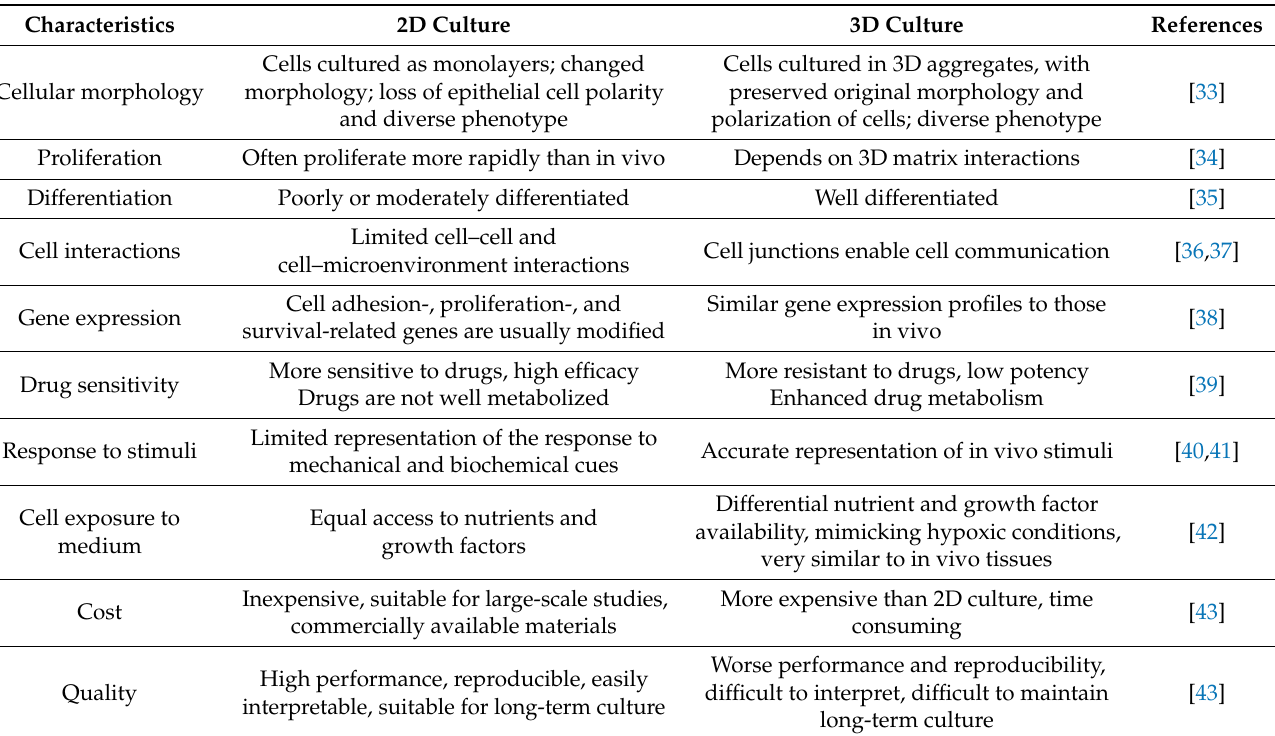
Table 1. Differences between 2D and 3D cell culture